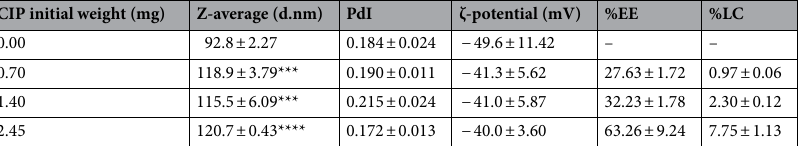
Table 1. Characteristics of the PEG–PLGA nanoparticles prepared using the S/O/W ion pairing method. *** and **** refer to the significant difference between the CIP-loaded PEG–PLGA nanoparticles and empty